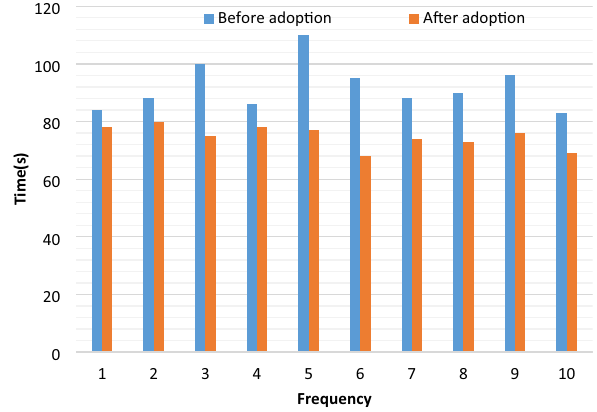
Fig. 6 Comparison of processing speed for malicious nodes